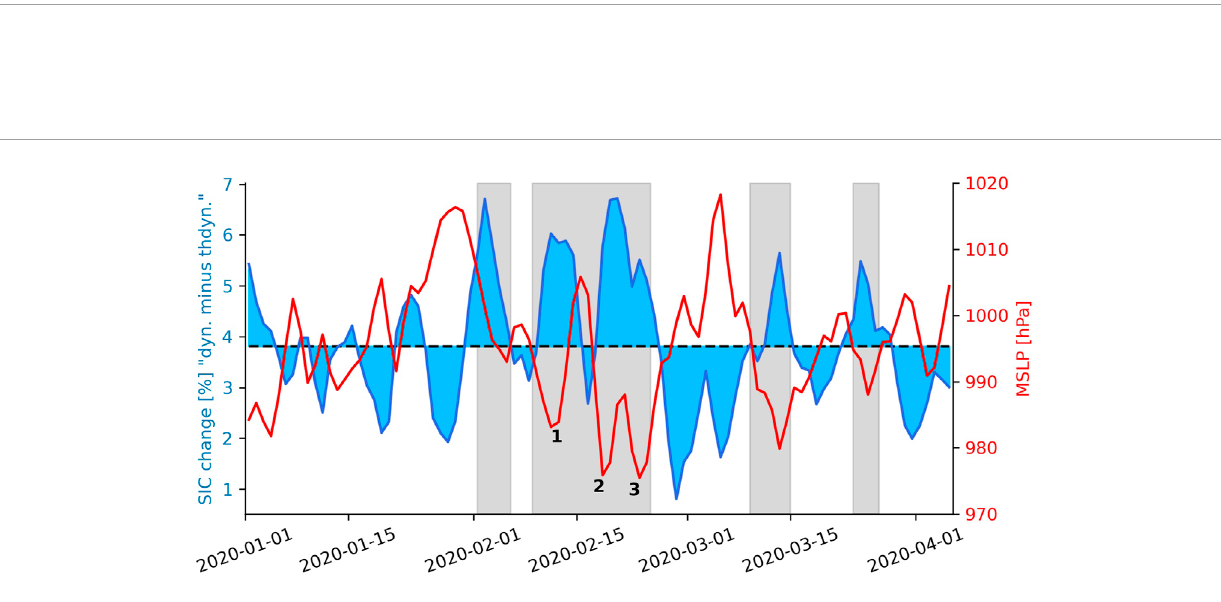
FIGURE 9 Difference of “absolute value of dynamic SIC change” minus “absolute value of thermodynamic SIC change” (blue line), both integrated over 5 days and averaged over the BKS (domain shown in Figure 4 ). Blue filled areas indicate the anomaly compared to the Jan. to March 2020 mean (black dotted line). Red line indicates SLP averaged over the BKS (domain shown in Figure 4 ). Grey areas highlight the main cyclone cases in Jan. to March 2020, numbers indicate the three cyclones analyzed in Section 3